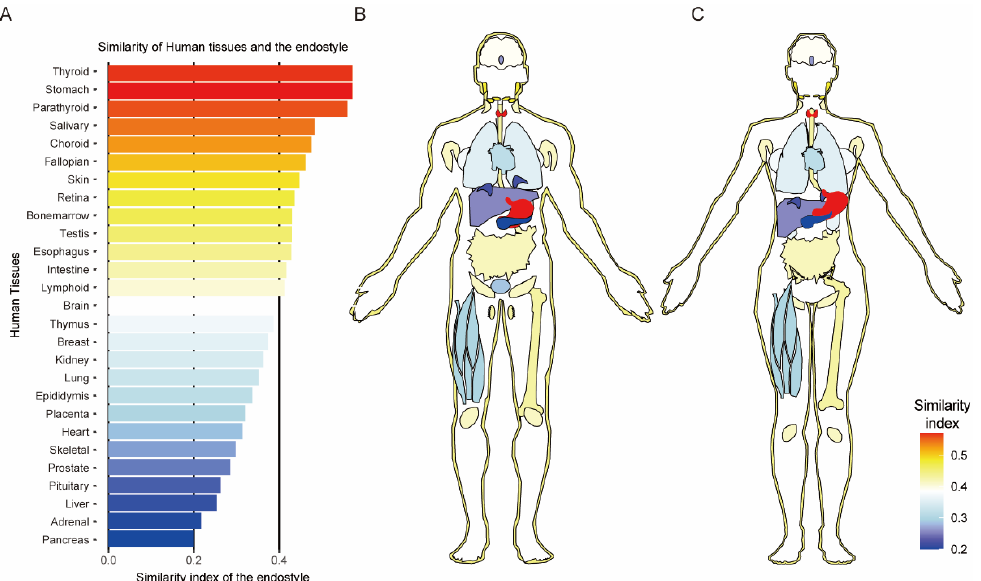
Figure 5. Transcriptional profile similarity between human tissue and the endostyle in S. clava . ( A ) Bar plot for similarity index in human organs corresponding to the endostyle; the similarity index is defined as the ratio of the highly expressed gene (FPKM > 5) of human organ-enriched marker gene homolog in the endostyle; if all homolog genes of human organ-enriched markers expressed in the endostyle with FPKM are larger than 5, the similarity index should be 1; ( B,C ) are similarity index projection on human organ anatomical graph.